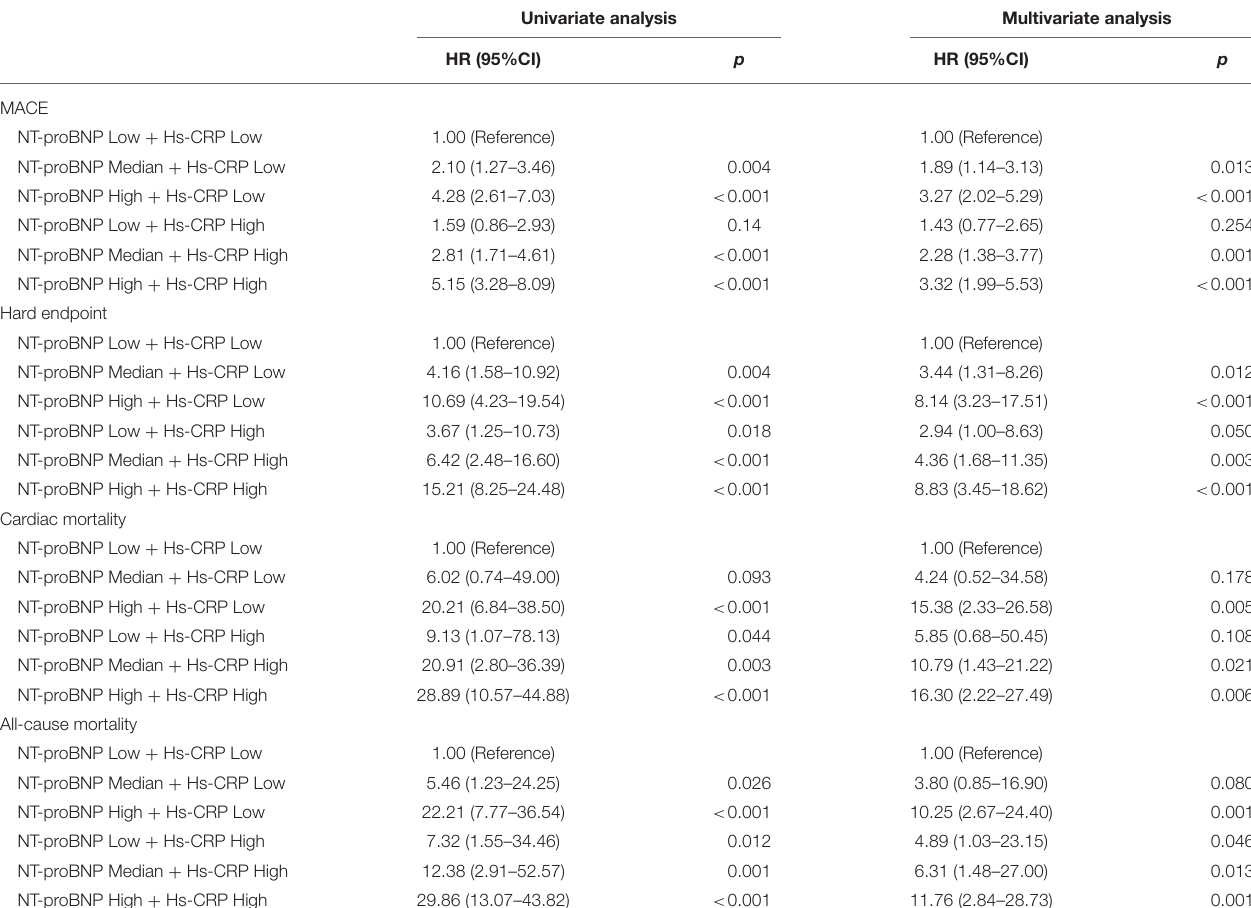
TABLE 3 | Univariate and multivariate Cox proportional hazards regression analyses of the combinations of NT-proBNP and hs-CRP for predicting cardiovascular